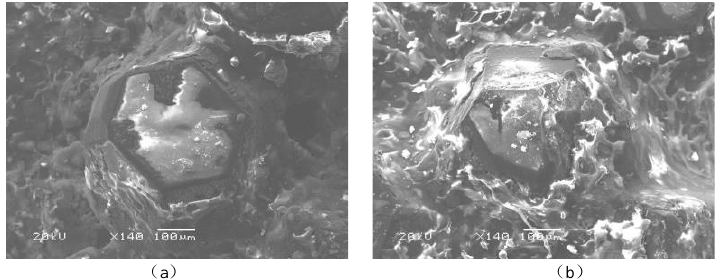
Figure 3. Change of single diamond grit: ( a ) initial state ( b ) abrasive wear and pose change. The machined chips and the corresponding grooved surface are of significance for the understanding of the cutting process. It would be much too difficult to capture and precisely measure the chips produced by single diamond grits because they are relatively small-scale. Therefore, the chips and scratches produced by diamond beads, instead of single diamond grits, were observed in our previous work [19]. The microscopic observation of the chips and corresponding grooved surfaces are shown in Figure 4a,b, respectively.